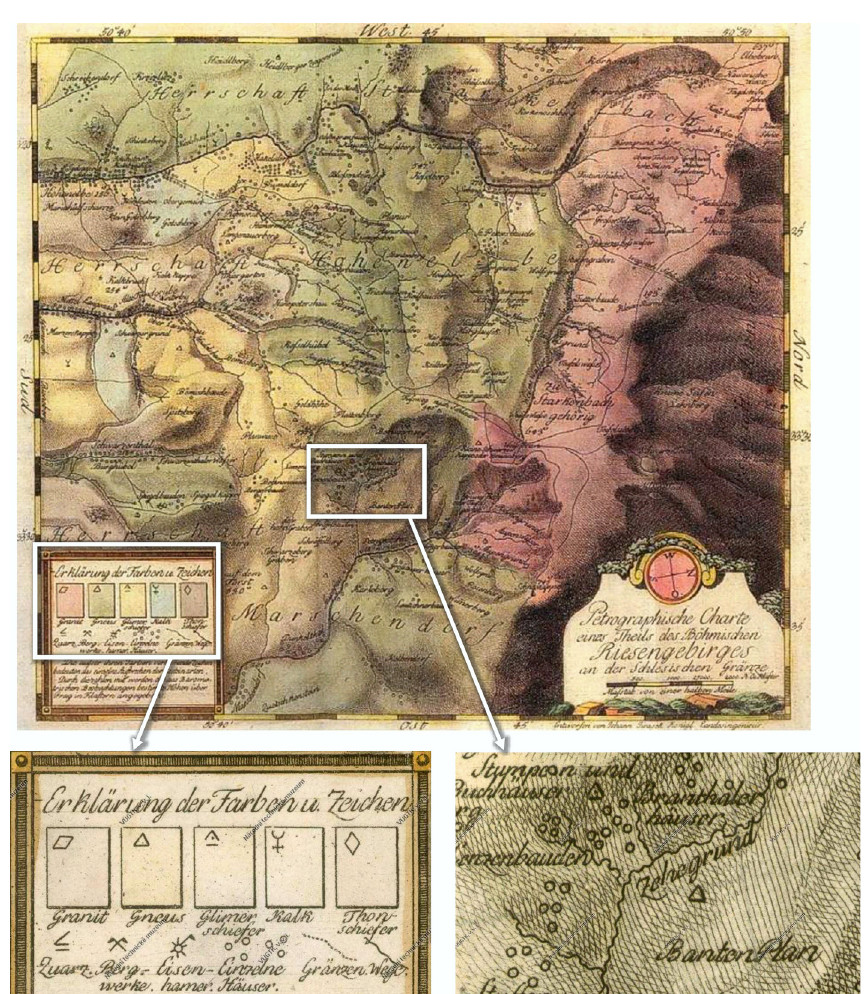
Fig. 9. A – the legend placed in the lower left corner of the map Petrographische Charte eines Theils de Böhmischen Riesengebirges an der Schlesischen Gränze by J. Jirasek, 1791, B – a part of the map with two extraction places of gneisses Gneus (triangles) and single houses (circles) marked (the collection of the Národní technické museum in